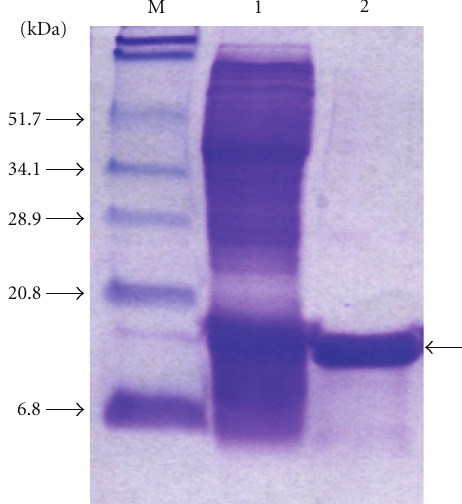
Figure 1: SDS-PAGE analysis of the purified rCFES. Lane M: Protein marker; Lane 1: IPTG-induced cell lysate; Lane 2: purified rCFES.